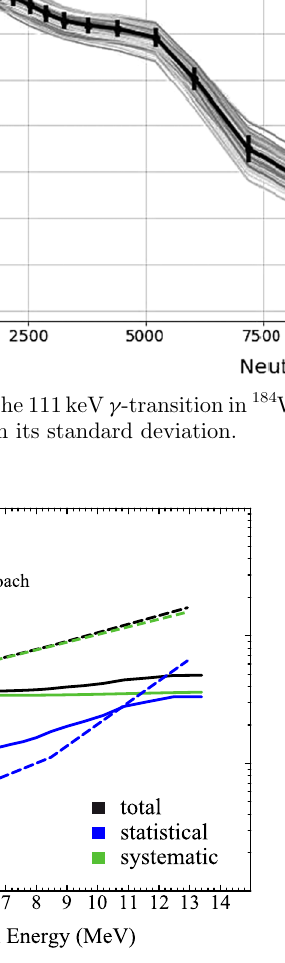
Fig. 5. Comparison of the relative uncertainties (cid:2) total, statistical and systematic (cid:2) of (n,xn g ) cross sections obtained using the deterministic method (line) and the Monte Carlo method (dashed line) for 122 keV g -transition in 186 W.